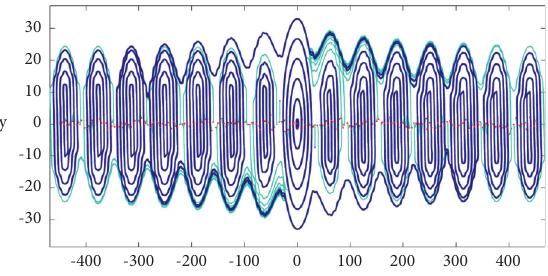
Figure 1: Coexisting limit cycles in System (1) resulted from random initial conditions distributed around the x -axis. Islands of attractors can be observed, consisting of 3, 4, and 5 limit cycles. Surprisingly 11 islands are enclosed by a huge limit cycle. The transients are shown in cyan, and steady states are shown in dark blue.